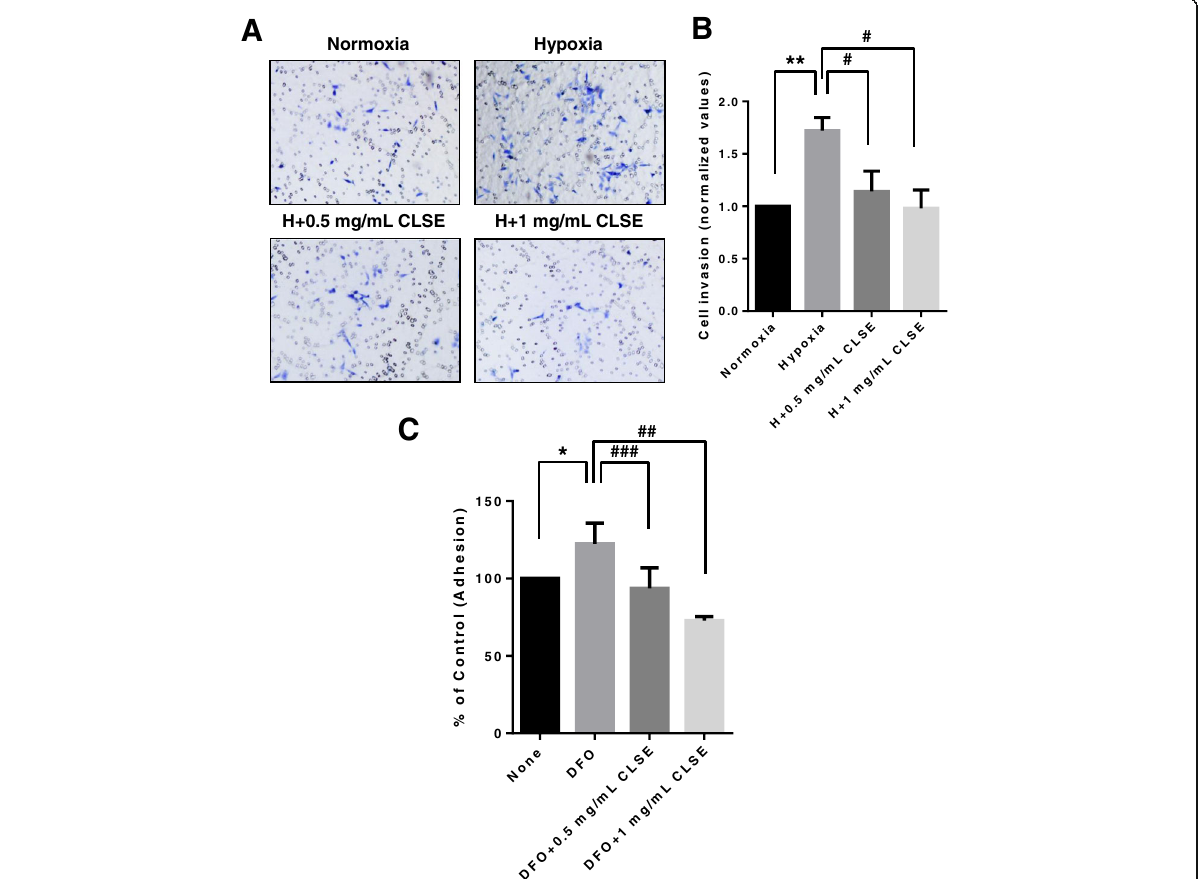
Fig. 3 Effect of CLSE on HCT116 cell invasion and migration under hypoxic conditions. a . Representative images showing the effect of CLSE on HCT116 cell invasion through a Matrigel®-coated Transwell® chamber membrane (magnification: 200×). After treatment with CLSE (0.5, 1 mg/mL) for 48 h under hypoxic conditions, cells that had invaded the transwells were analyzed through crystal violet staining. b . Number of HCT116 cells that invaded following CLSE treatment. The values are normalized to the number of invaded control cells (normoxia). ** p < 0.01 versus normoxia control group. # p < 0.05 versus hypoxia-only group. c . After treatment with DFO (100 μ M) and/or CLSE (0.5, 1 mg/mL) for 24 h, cells were seeded into Matrigel-coated wells and then analyzed using an MTT assay. Number of HCT116 cells that adhered to the Matrigel®-coated plate following CLSE treatment. The values are normalized to the number of adherent control cells (untreated). * p < 0.05 versus untreated control group. ## p < 0.01, ### p < 0.001 versus DFO-only groups. Data are mean ± SD ( n = 3). CLSE, Coix lacryma-jobi var. ma-yuen Stapf sprout extract; H, hypoxia; SD, standard